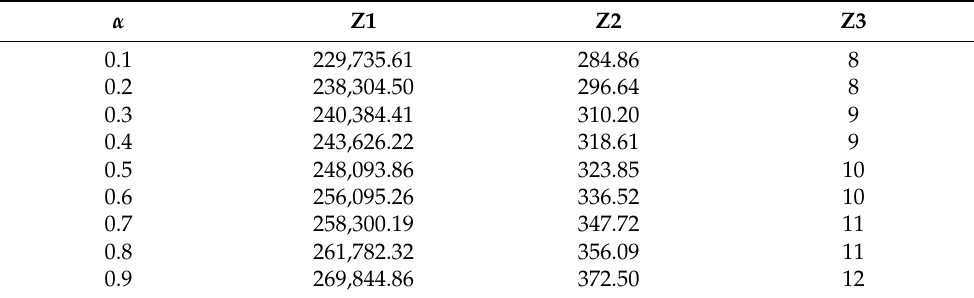
Table 9. Trend of changing the values of objective functions for different uncertainty rates.